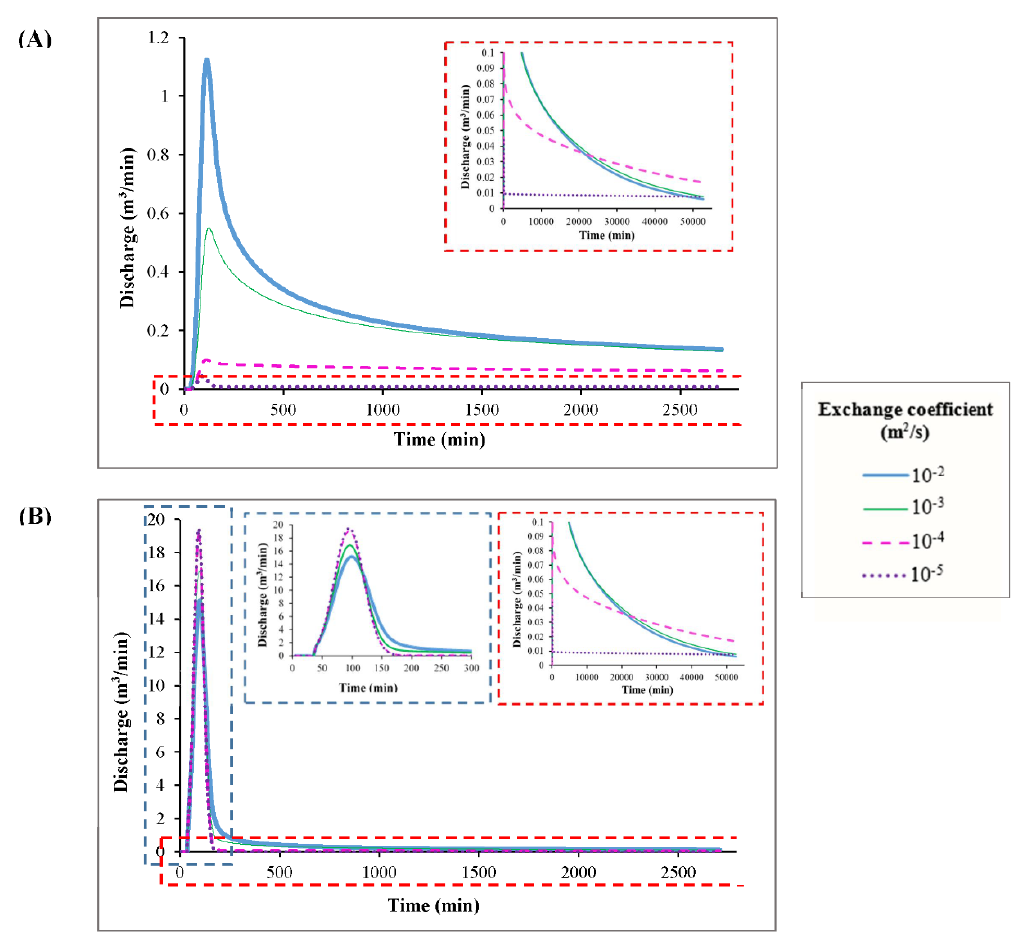
Figure 4. Spring hydrograph variability in the relation to the exchange coefficient changes in scenarios A1 ( A ) and B1 ( B ).